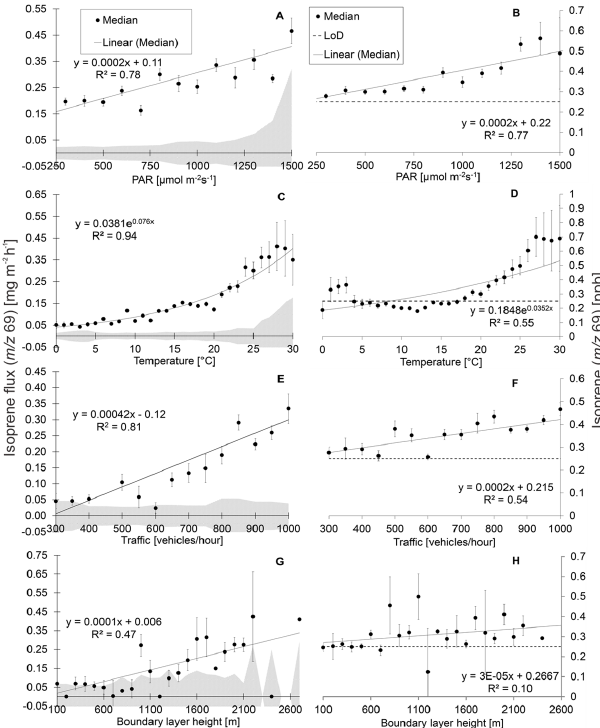
Figure 3. Examples, using isoprene, of averaged VOC fluxes (left) and mixing ratios (right) as a function of photosynthetically ac- tive radiation (PAR) (µmolm − 2 s − 1 ), temperature ( ◦ C), traffic den- sity (vehiclesh − 1 ) and boundary layer mixing height (m) based on 25min VOC means with linear or exponential regressions, formu- lae, R 2 values and detection limit (shaded area for fluxes and dashed line for mixing